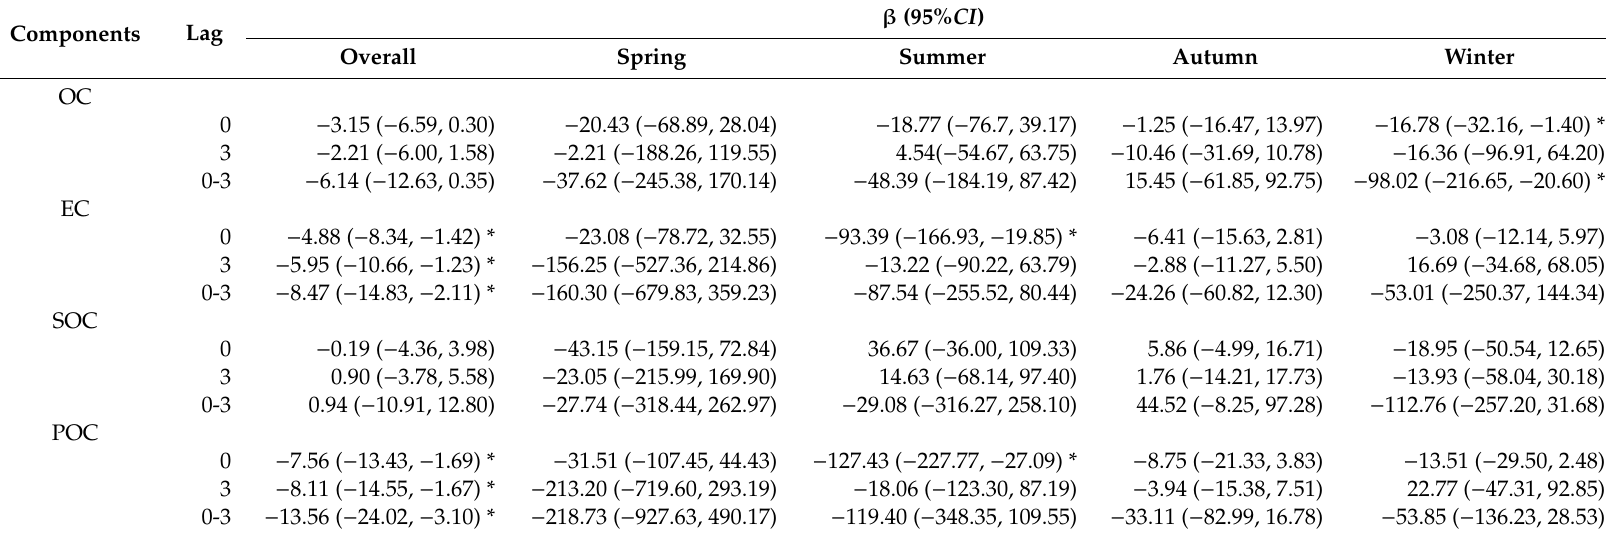
Table 3. Estimated health e ff ects on evening PEF (L / min) with 10 µ g / m 3 increase of indoor pollution in constituent-PM 2.5 model in di ff erent periods. β (95% CI ) Components Lag Spring Summer